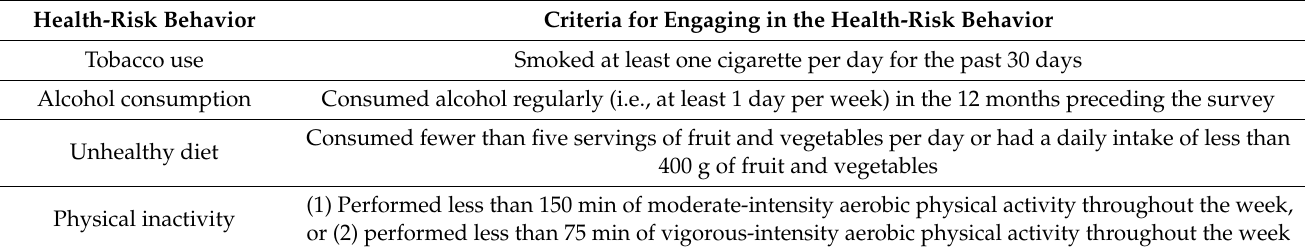
Table 1. Criteria for determining engagement in health-risk behaviors. Health-Risk Behavior Criteria for Engaging in the Health-Risk